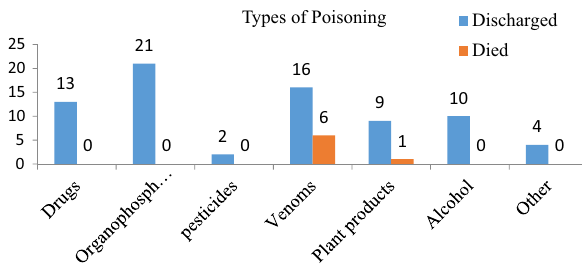
Figure 1. Overall distribution of poisoning cases with short-term outcomes.